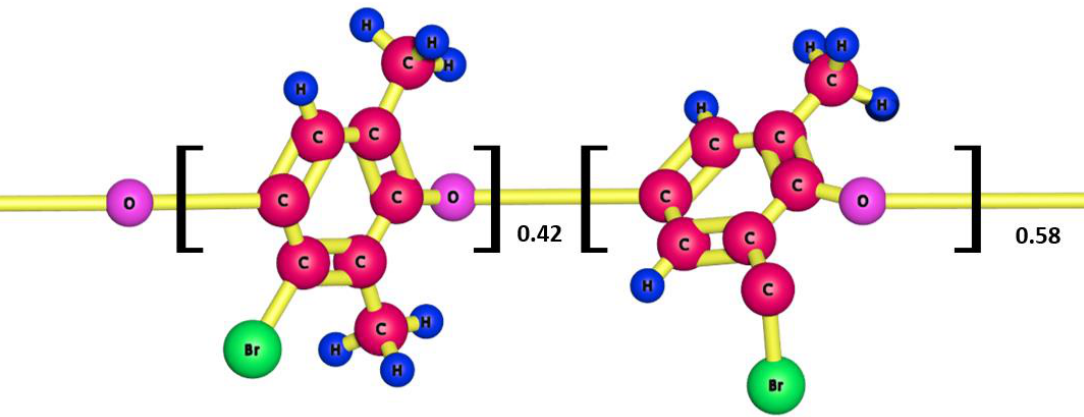
Figure 3. A three dimensional (3D) structure of brominated poly (2,6-dimethyl 1,4-phenylene oxide) (BPPO).